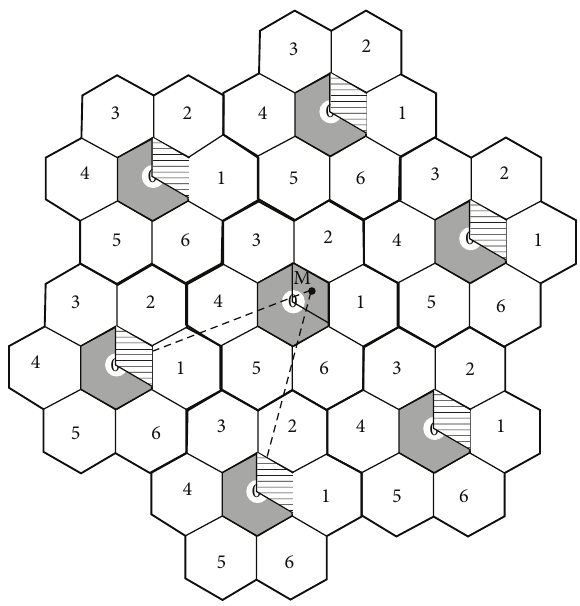
Figure 1: Cellular network architecture for the movement of